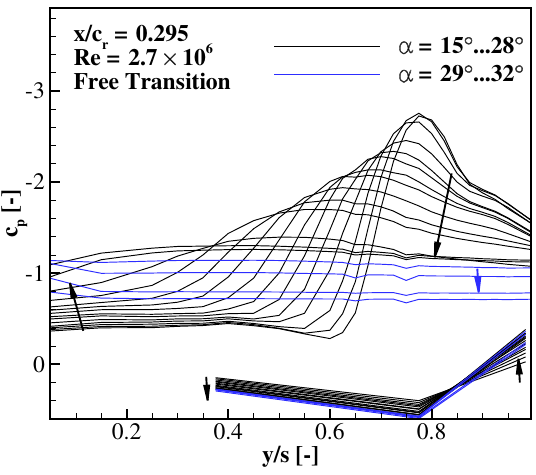
Figure 6. Spanwise distribution of the pressure coefficient as function of angle of attack α , at 10 ◦ , for free transition conditions; arrows towards increasing α x / c r = 0.295 and Re = 2.7 ×